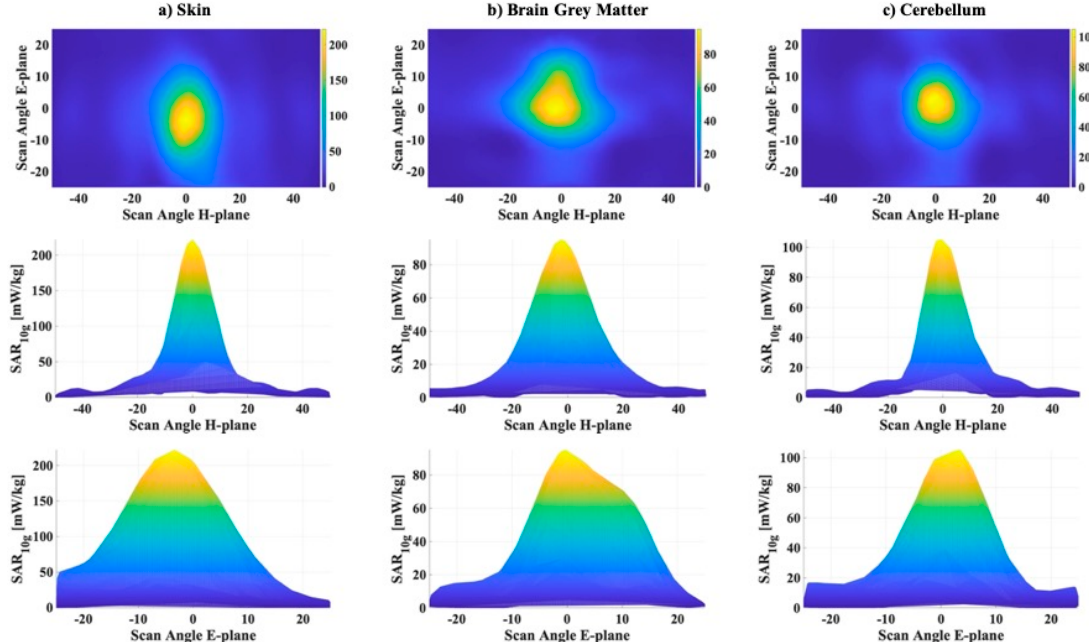
Figure 7. Maximum SAR levels mediated on 10 g for 1000 combinations of azimuth and elevation angles for ( a ) the skin, ( b ) the grey brain matter, and ( c ) the cerebellum. The first row shows the maps as a function of the azimuth and elevation angles; the second row shows the graphs, extracted from the maps, fixed the elevation angle to 0°; the third row shows the graphs, extracted from the maps, fixed the azimuth angle to 0°. Table 3. The QDC values, the percentage of 𝑆𝐴𝑅 (cid:2869)(cid:2868)(cid:3034) higher than the 70% of the maximum values and the variation range extremes of the two input parameters for the skin, for the brain grey matter and for the cerebellum. Skin Brain Grey Matter Cerebellum QDC 67.4% 74.6% 76.0% % > 𝟎. 𝟕 ∙ 𝒎𝒂𝒙𝒊𝒎𝒖𝒎 3.3% 4.2% 2.8%